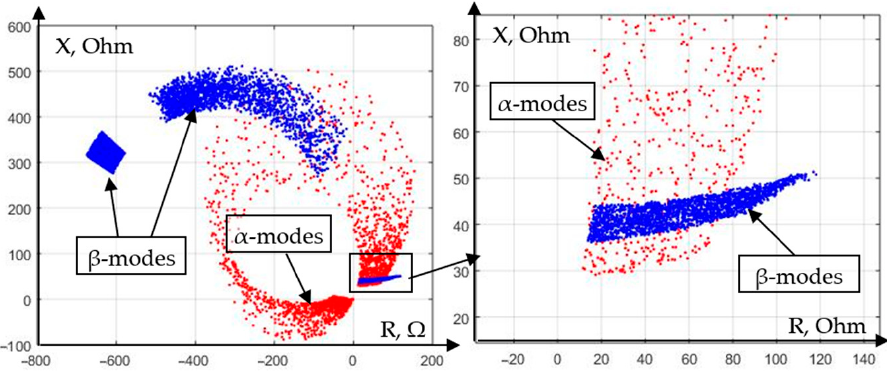
Figure 18. Distribution of α - and β -modes of the classifier “SVM ω 2 ” on the complex plane.